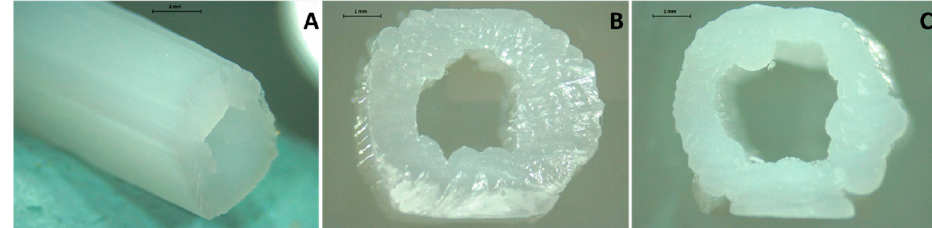
Figure 1. Representative images of a blank tubular graft ( A ) cross-section of a blank tubular graft ( B ) and a tubular graft containing 10% ( w / w ) of ASA ( C ) Scale bars: panel A : 2 mm; panel B , C : 1 mm.